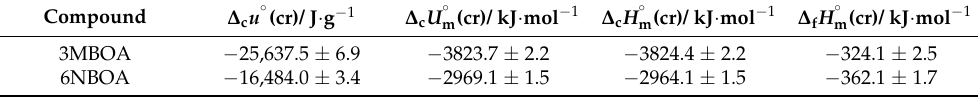
Table 1. Standard ( p ◦ = 0.1 MPa) massic energy of combustion, ∆ c u ◦ , molar energy of combustion, ∆ c U ◦ m , enthalpy of combustion, ∆ c H ◦ m , and enthalpy of formation, ∆ f H ◦ m , for the studied compounds, at T = 298.15 K. 1